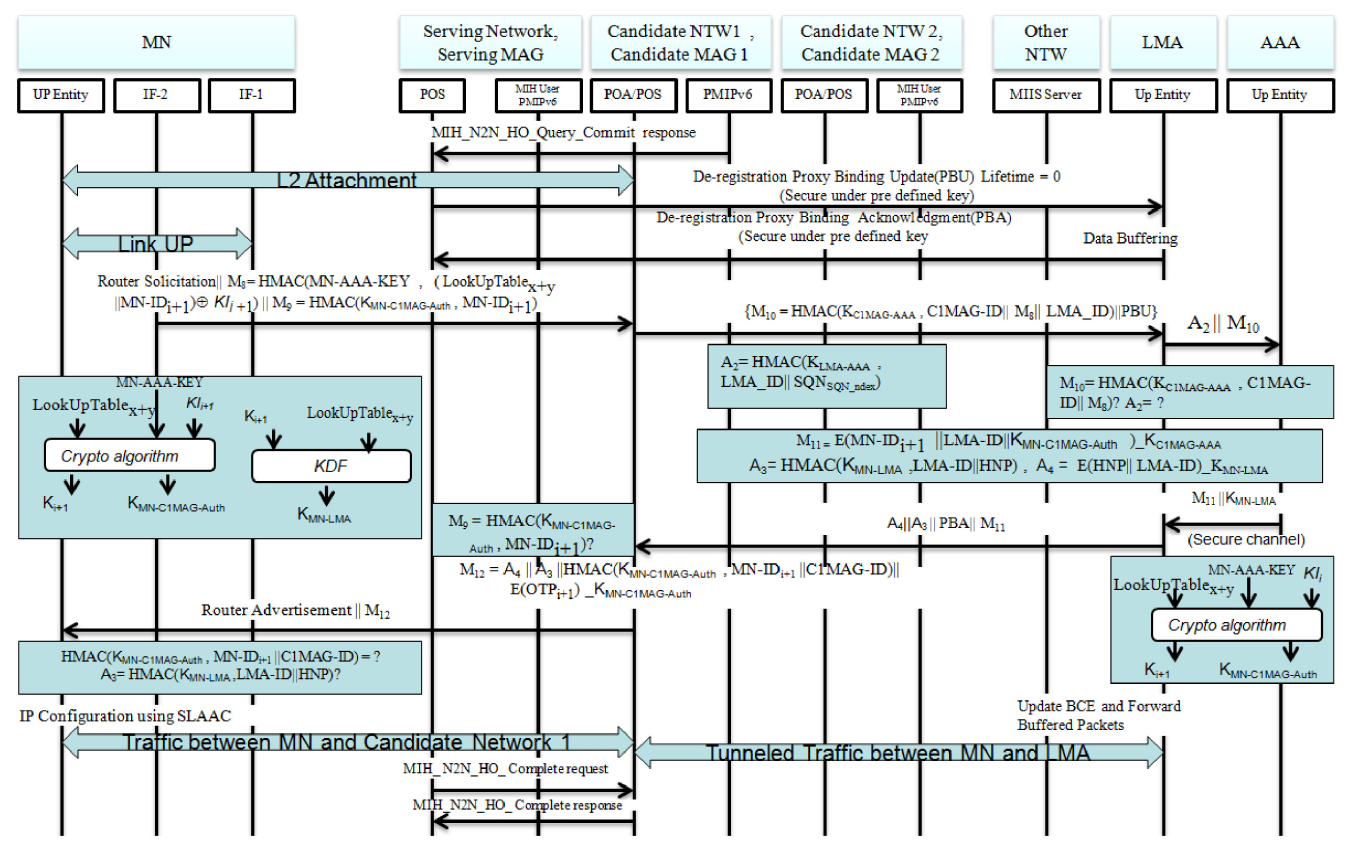
Fig 4. Secure MIH enabled PMIPv6 handover protocol